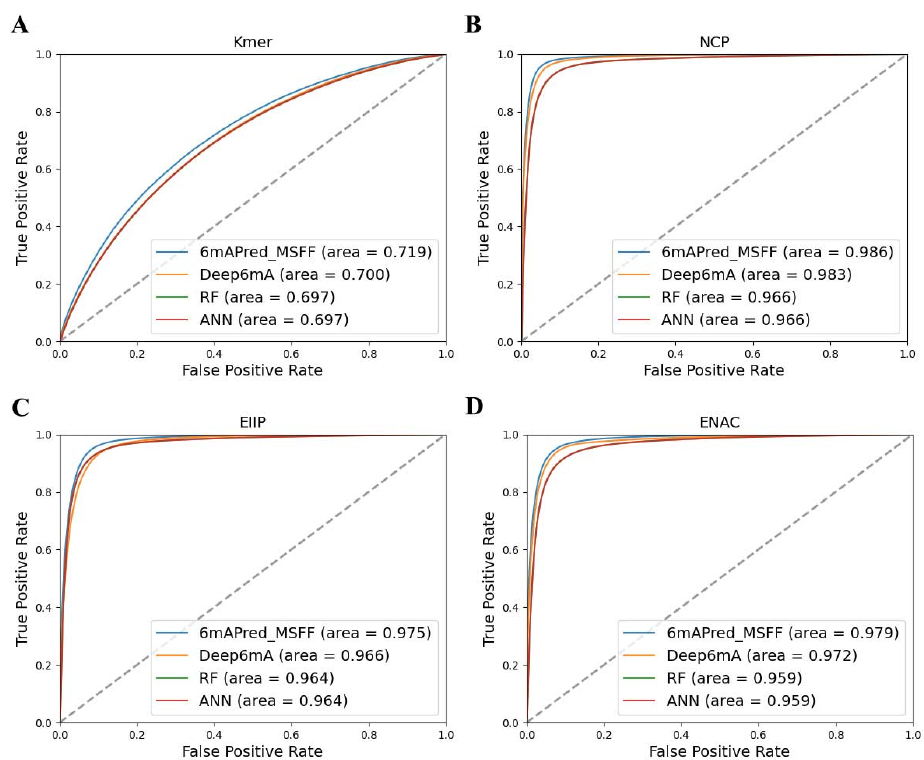
Figure 4. The ROC curves ( A – D ) of four models (6mAPred-MSFF, Deep6mA, SNNRice6mA-large, and MM-6mAPred) based on four feature descriptors (Kmer, NCP, EIIP, ENAC).